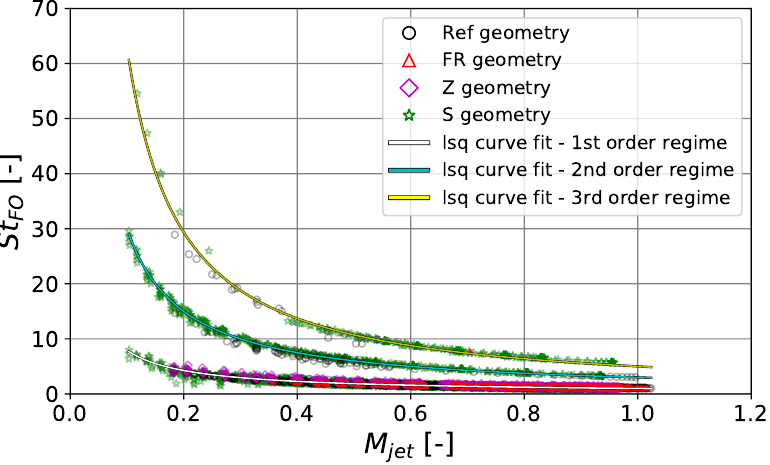
Figure 16. Non-dimensional characteristic of the FO-PJA family, first-, second- and third- order